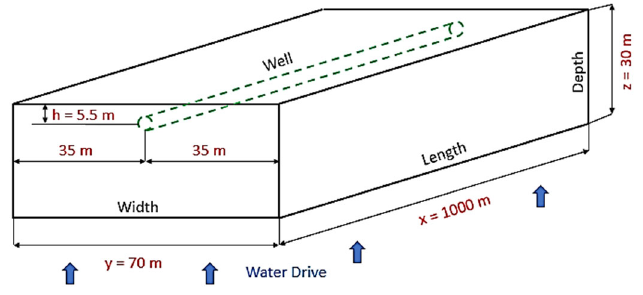
Figure 2. Schematic of the well and reservoir.